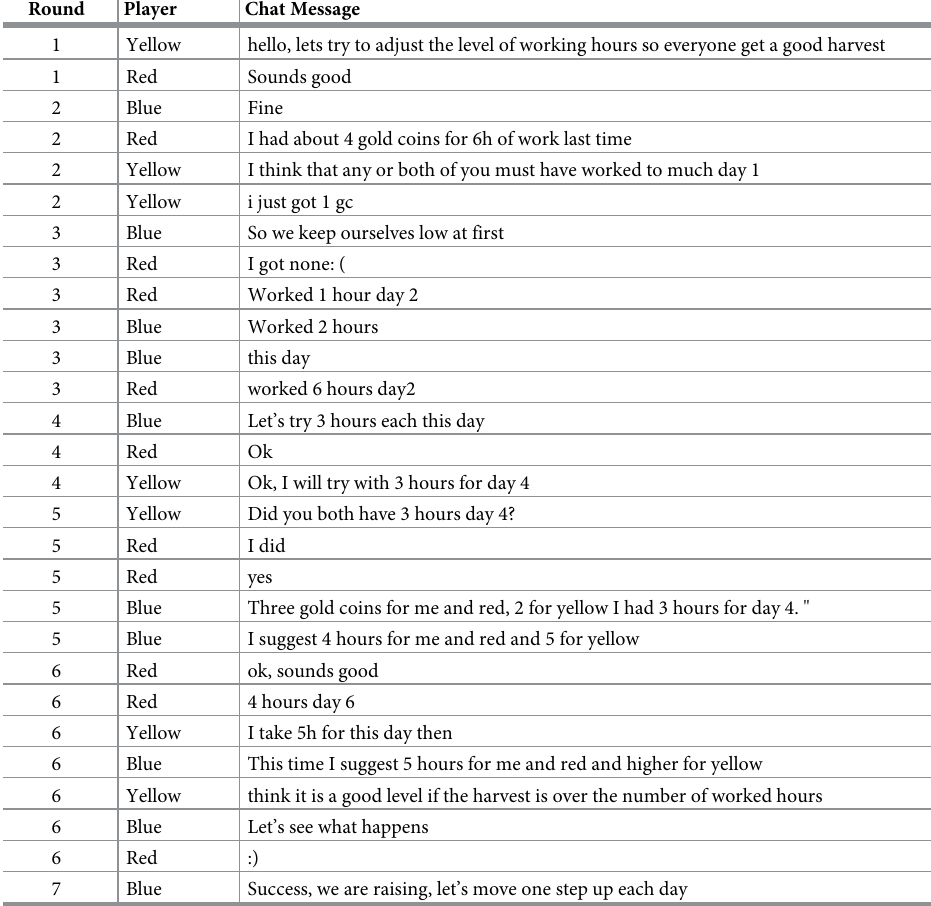
Table 6. Chat 1—No Information, constructive